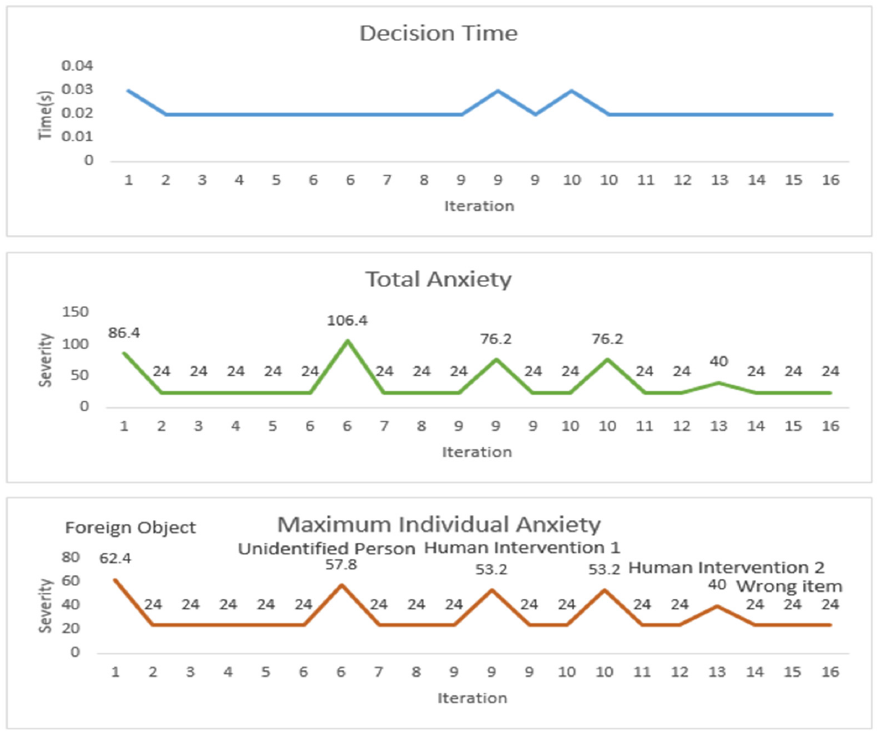
Figure 9. Anxiety evaluation and counter strategy decision time. The quantitative analysis from the survey was carried out; the overall mean auto- mated decision-time (MADT) for the proposed method and accuracy of both approaches were calculated with a minimum of two situations in each cycle. It was revealed that the mean automated decision time for a contingency is 0.21 s, as can be seen in Table 5. The decision-making system (accuracy of 89.98%) was found to be 16.85% more accurate than the standard system (accuracy of 73.125%). The t -test for the significance of the results was conducted with a confidence level set to p < 0.05 (95% confidence level), and the p -value for the test was found to be p < 0.01. The standard error mean (SEM) for the MADT was found to be 9.36 × 10 − 5 , the upper limit was found to be 0.0211 s, and the lower limit was 0.0208 s. Table 5. Accuracy of two methods: mean automated decision-time and the SEM. Subject